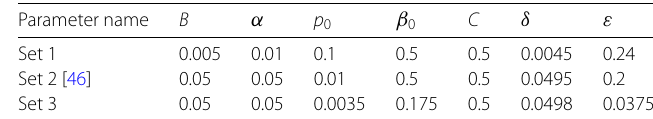
Table 8 Values of parameters used for numerical simulation of HIV model